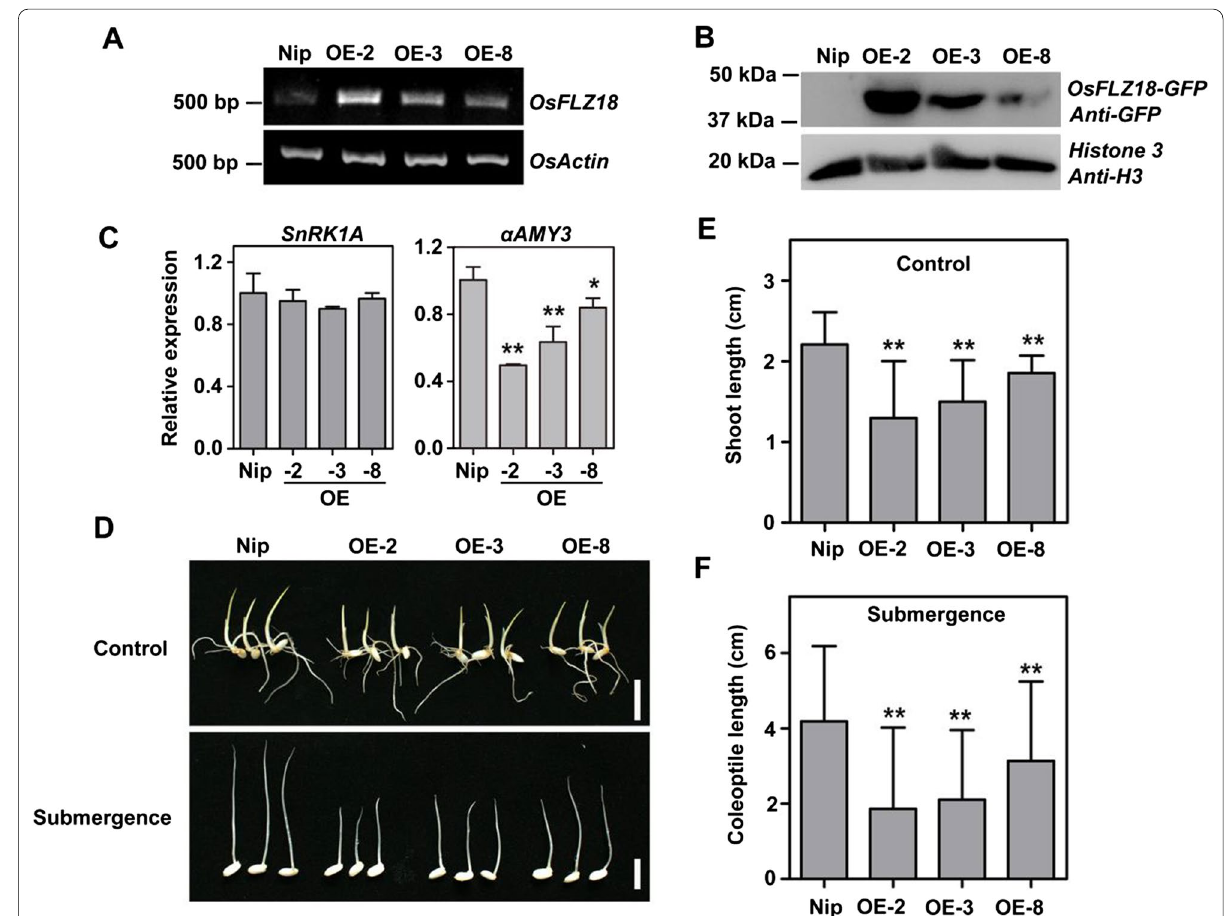
Fig. 7 OsFLZ18 negatively regulates early seedling growth in air and coleoptile elongation under submergence stress. a Relative expression of OsFLZ18 in WT and three OE transgenic lines by qRT-PCR. b Protein accumulations of OsFLZ18-GFP in WT and three OE transgenic lines by Western Blotting. Total protein was extracted from seedlings, and antibodies against GFP and Histone 3 were used in this assay. c qRT-PCR analysis of the transcriptional levels of SnRK1A and αAmy3 in WT and OE transgenic lines. * p < 0.05, ** p < 0.01, Student’s t -test. d Phenotypes of WT and OE transgenic lines in air and under submerged conditions. Sterile seeds were germinated for 7 days in air and under complete submergence. Bars 1 cm. e , f Statistical data for the shoot lengths ( e ) or coleoptile lengths ( f ) of WT and OE transgenic plants shown in ( d ) (n > 30). ** p < 0.01, = Student’s t